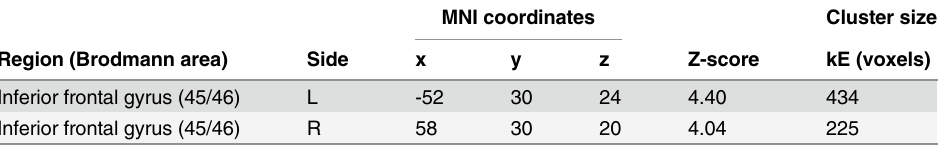
Table 3. Regional gray matter volume decreases in AN patients compared with the control group.